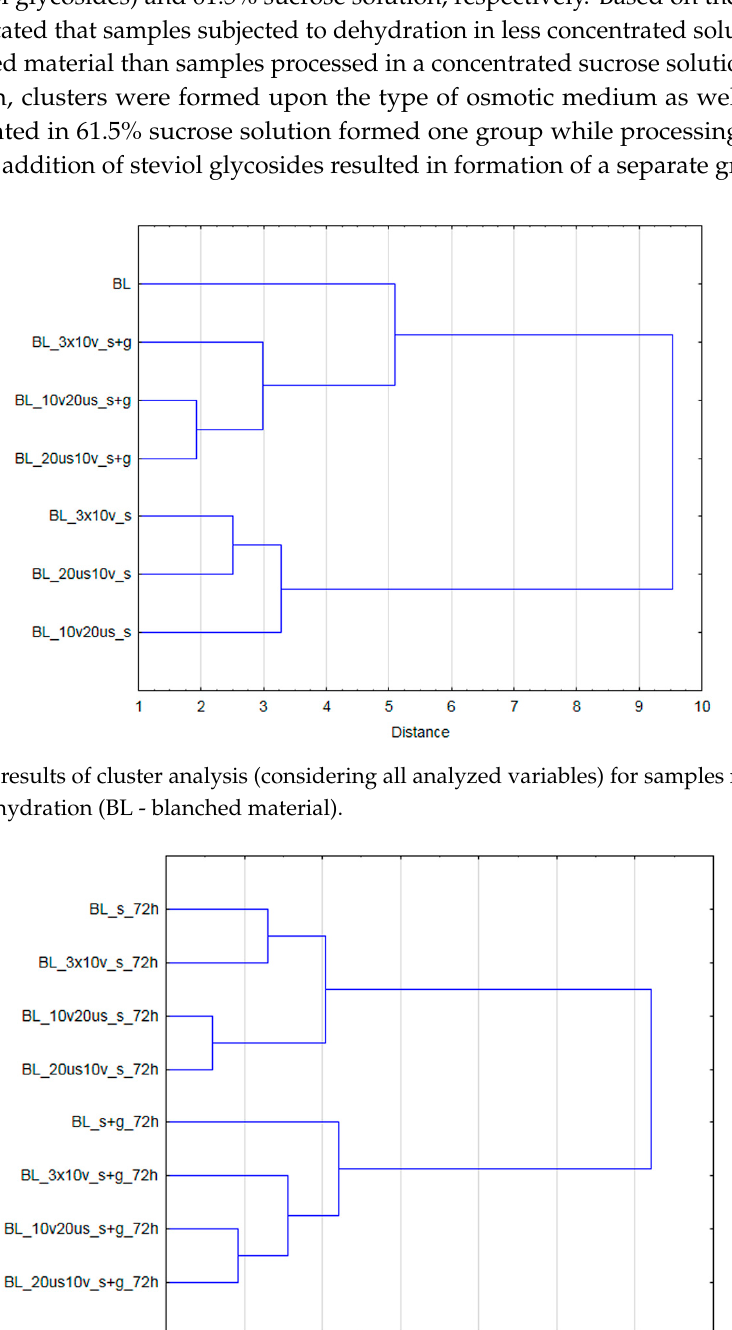
Figure 5. Anthocyanins content in different treated cranberries: Blanched (BL), reduced pressure (BL_3 × 10 v), reduced pressure with sonication treatment (BL_10 v 20 us), sonication treatment with reduced pressure (BL_20 us 10 v), and after osmotic dehydration (OD) in 61.5% sucrose solution (s) and in 30% sucrose solution with 0.1% addition of steviol glycosides (s + g). Different lowercase letters means significant difference by the Duncan test ( p < 0.05) for samples after treatment, and different